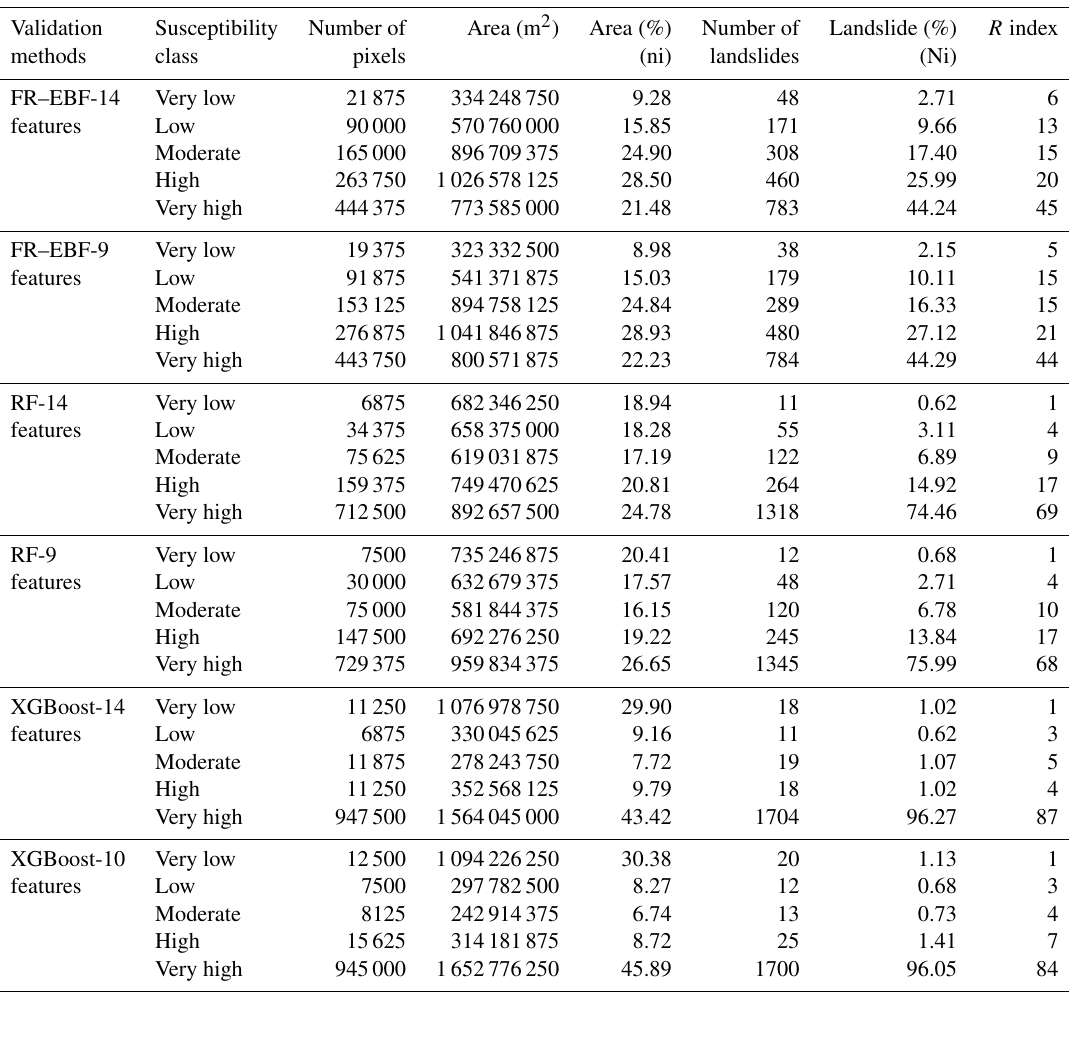
Table 4. R indices for the FR–EBF, RF, and XGBoost models’ landslide susceptibility mappings (LSMs).